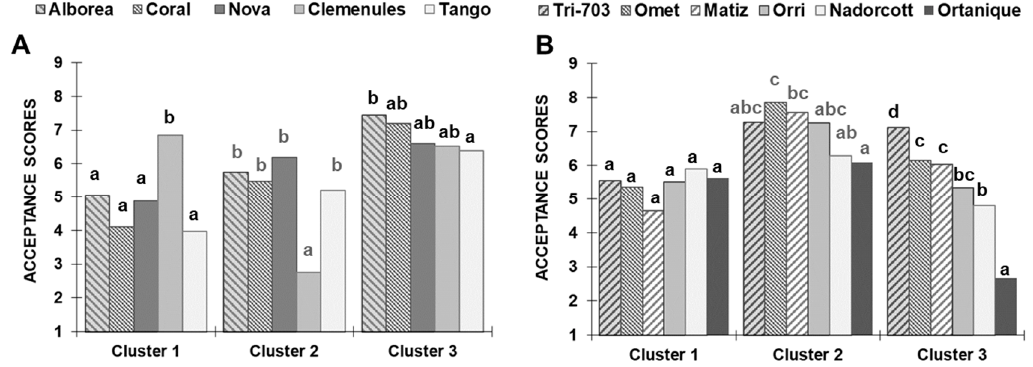
Figure 2. Mean acceptance scores of consumers (Clusters 1–3) who evaluated: Harvest 1 cultivars ( A ); and Harvest 2 cultivars ( B ). For each harvest, scores not sharing letters within each cluster were significantly different ( p ≤ 0.05) according to Kruskal–Wallis test (two-tailed).